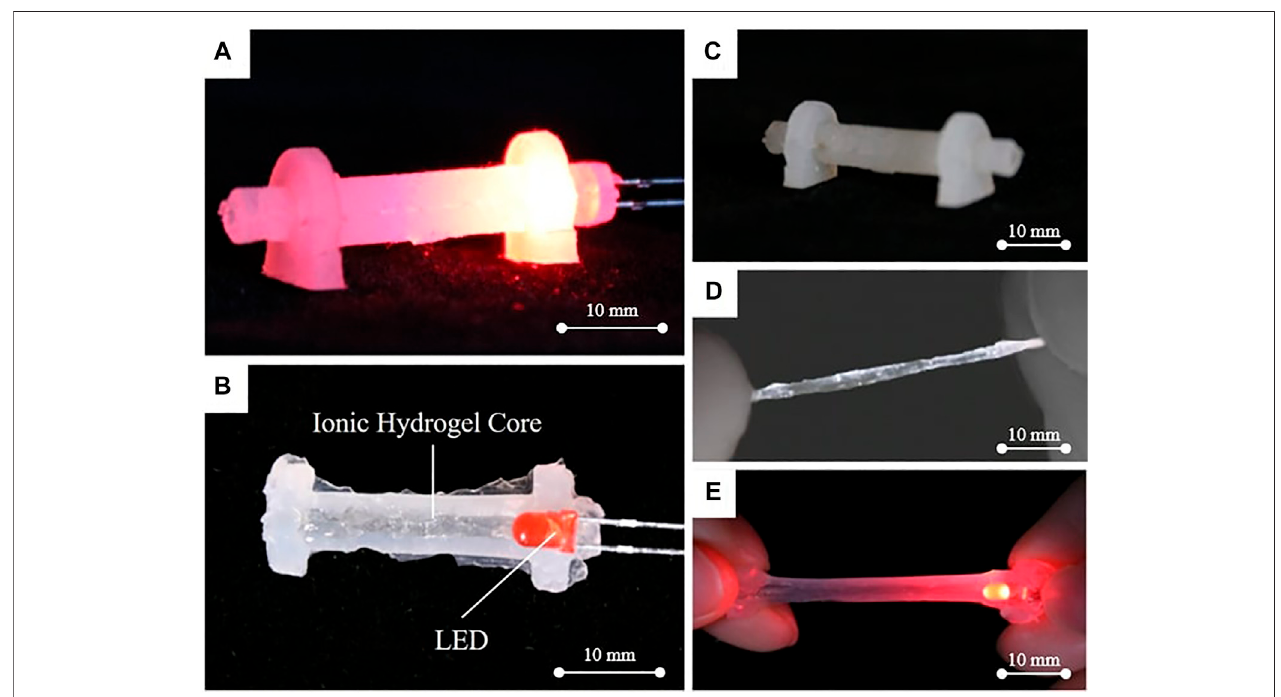
FIGURE 1 | The proposed MHS Sensor. (A) The fabricated MHS Sensor with LED operated. (B) The cross section of the MHS Sensor. (C) The silicone cladding. (D) The solidi fi ed hydrogel with high intrinsic transparency. (E) The MHS Sensor with high stretchable ability.